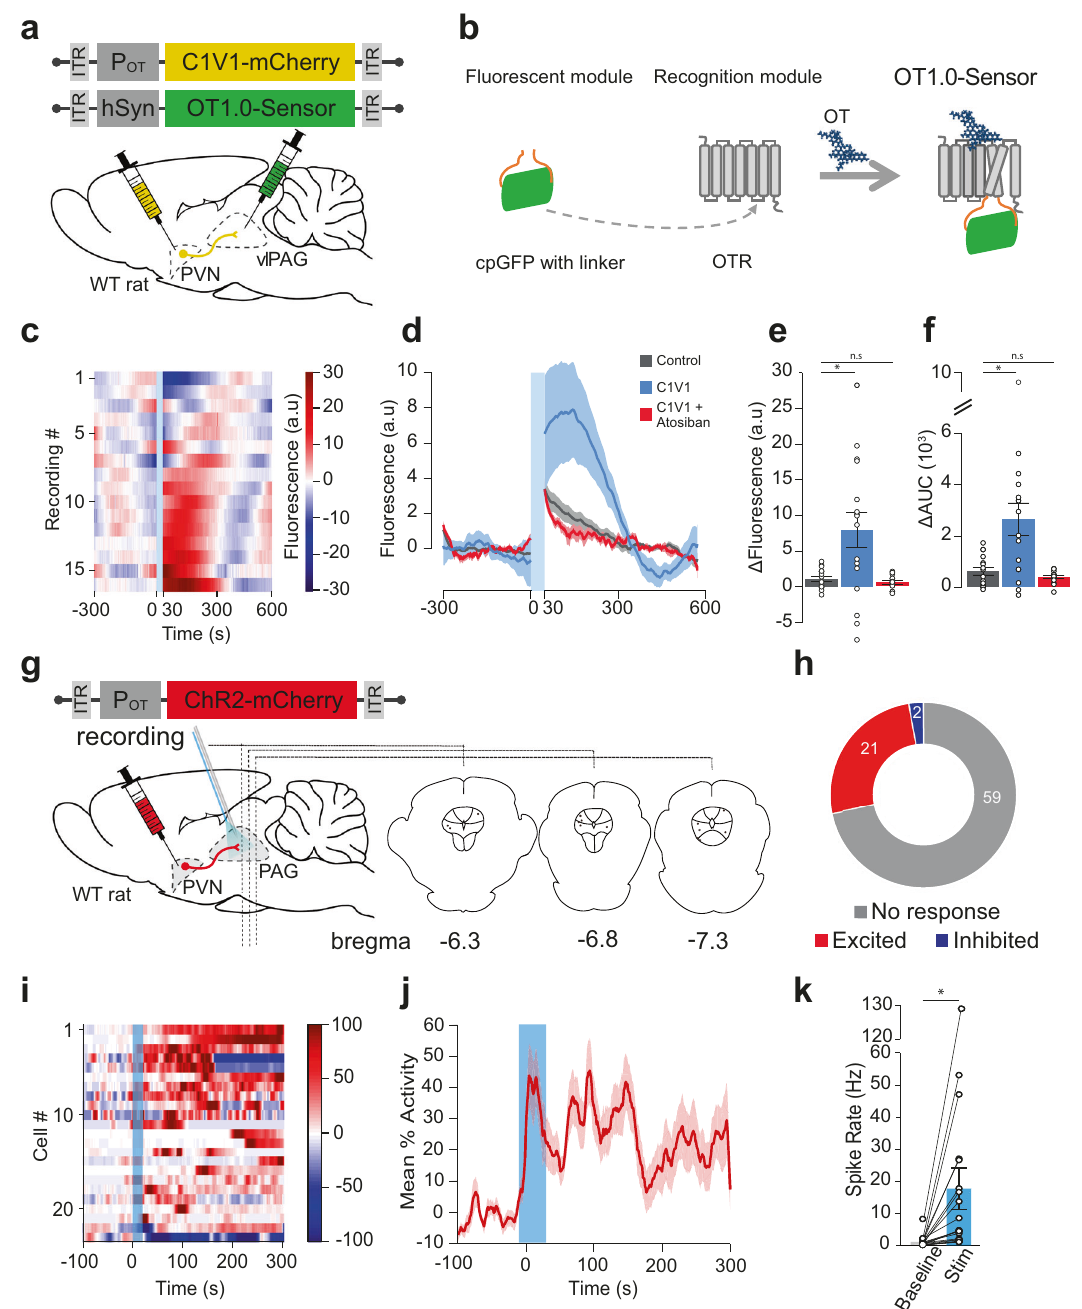
Fig. 4 | Endogenous OTrelease inthe vlPAG increasesvlPAG neuronactivityin female rats. a Schema of injections of rAAV 1/2 -pOT-C1V1-mCherry in the PVN and rAAV 1/2 -hSyn-OT1.0-sensor in the vlPAG. b Schema depicting the principle behind the GRAB OT sensor 18 . c Fluorescence signal of the C1V1 condition in the vlPAG (n recordings = 16; n slices =7; n rats =3). Blue band at 0s correspond to the yellow sti- mulation(30mspulseat20Hzfor30s). d Mean fl uorescence(line)±SEM(shaded) ofthecontrol(gray),C1V1(blue),andC1V1+atosiban(red)recordingsinthevlPAG. e Delta of the max fl uorescence value between the period before the light stimu- lation ( − 300to 0s) and theperiodfollowing the light stimulation (0to 300s).The delta of the three conditions are represented. Welch ’ s ANOVA test (W=6.934, p =0.0045, n =16) followed by Dunnett ’ s T3 multiple comparison post hoc test (two-sided): Control vs C1V1: *p adj =0.0272; Control vs C1V1+Atosiban: p adj: = 0.3133. f Delta of the mean Area Under the Curve (AUC) between the period before the light stimulation ( − 300 to 0s) and the period following the light sti- mulation (0 to 300s). The delta of the three conditions are represented. Welch ’ s ANOVA test (W=6.934, p =0.0045, n =16) followed by Dunnett ’ s T3 multiple